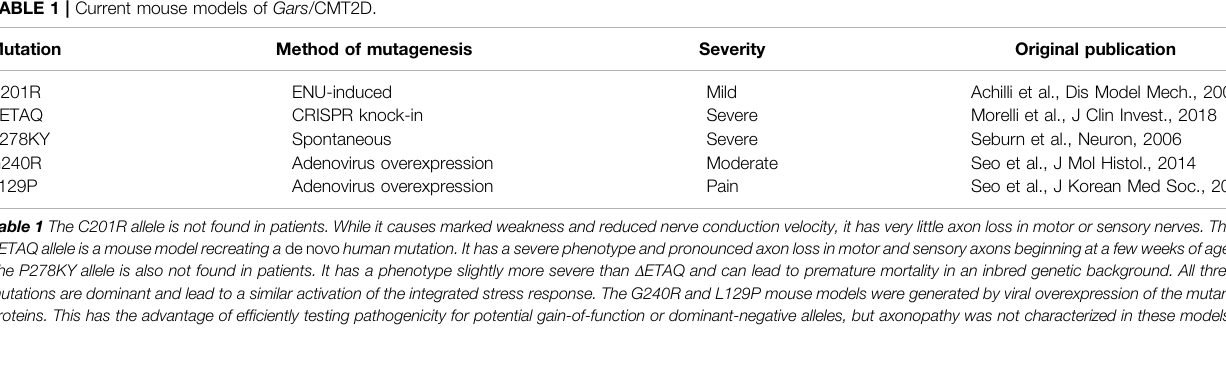
Frontiers in Cell and Developmental Biology |